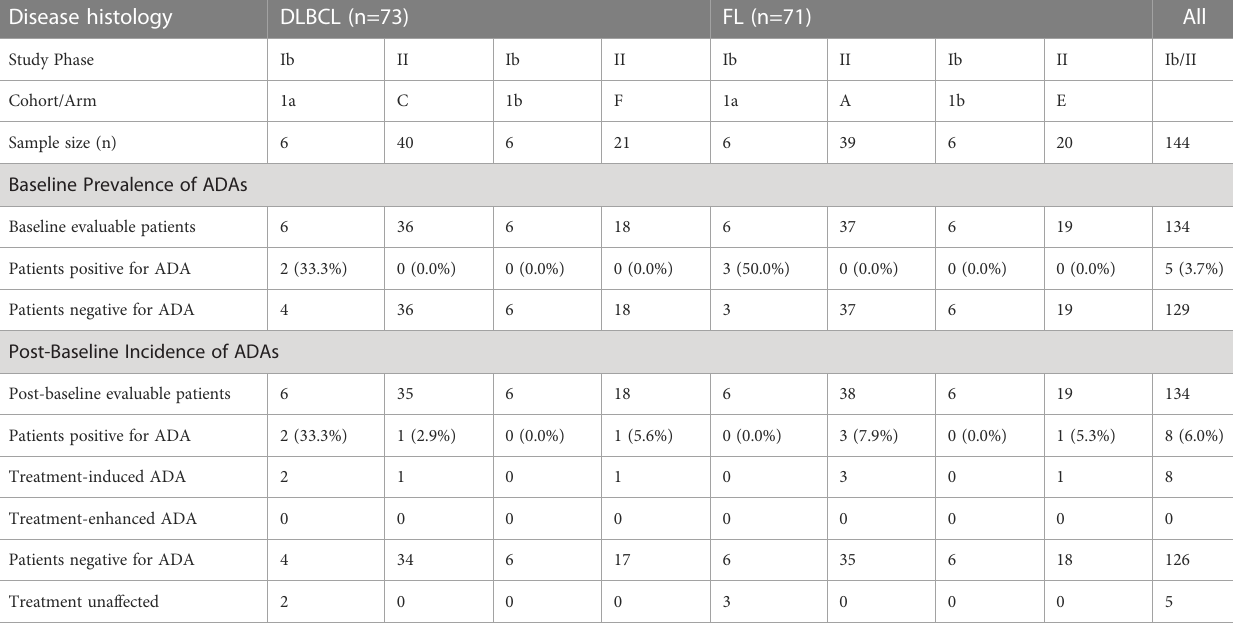
TABLE 2 Incidence of ADAs to polatuzumab vedotin in study GO29365. Disease histology DLBCL (n=73)